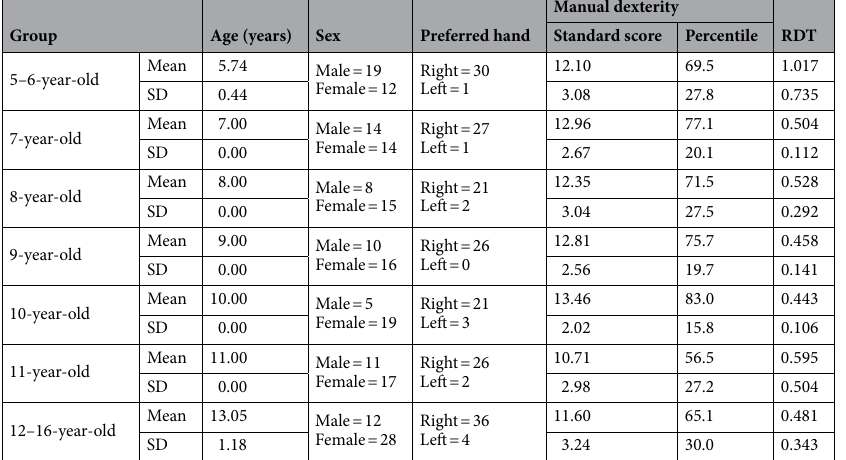
Group Age (years)